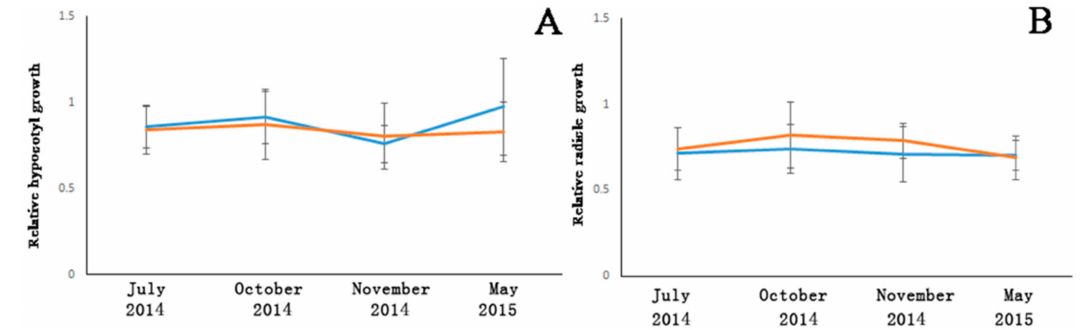
Figure 1. Changes in the allelopathic activity of leaf tissue from transgenic (blue) and non-transgenic (orange) Populus for relative hypocotyl ( A ) and radicle ( B ) growth compared to blank controls in different sampling time points as determined by the sandwich method. No significant difference was detected between the transgenic group and the non-transgenic group on respective samplings points ( α =